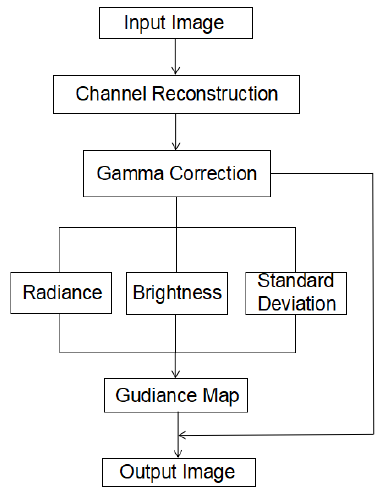
Figure 1. Algorithmic structure of the proposed method. The algorithm process mainly involves the following steps: (1) image input; (2) channel reconstruction; (3) gamma correction; (4) generating the guidance map c according to Equation (14); (5) restoring the RGB channels I l in the tone mapped result by Equation (12); k (6) resulted image